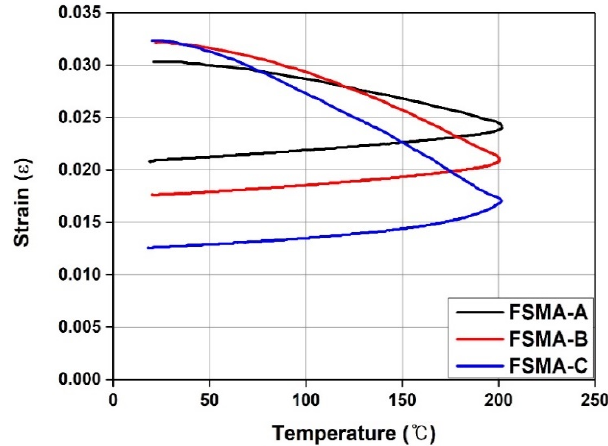
Figure 6. Comparison of temperature ‐ recovery strain curves under free restraint. Table 5. Summary of activation test result under free restrains.